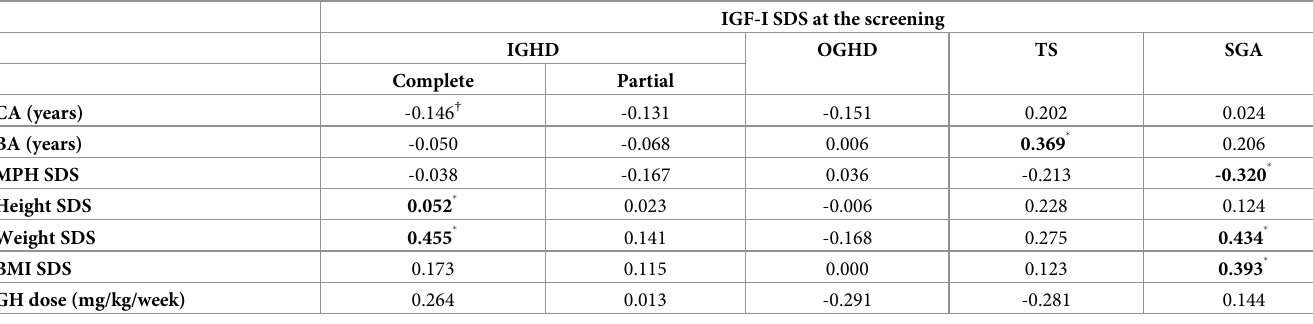
Table 2. Correlations between the IGF-I concentration and screening